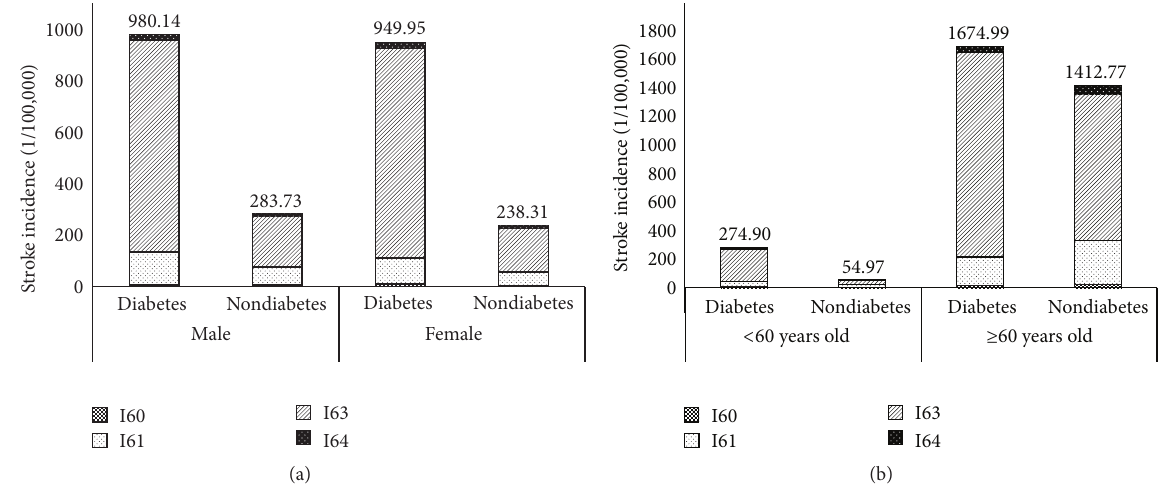
Figure 2: Stroke incidence for the diabetic and nondiabetic populations by age and sex in 2007–2013 in Zhejiang Province. (a) Stroke incidence in male and female. (b) Stroke incidence grouped by age. I60: subarachnoid hemorrhage; I61: intracerebral hemorrhages; I63: cerebral infarctions; and I64: unspecified strokes.